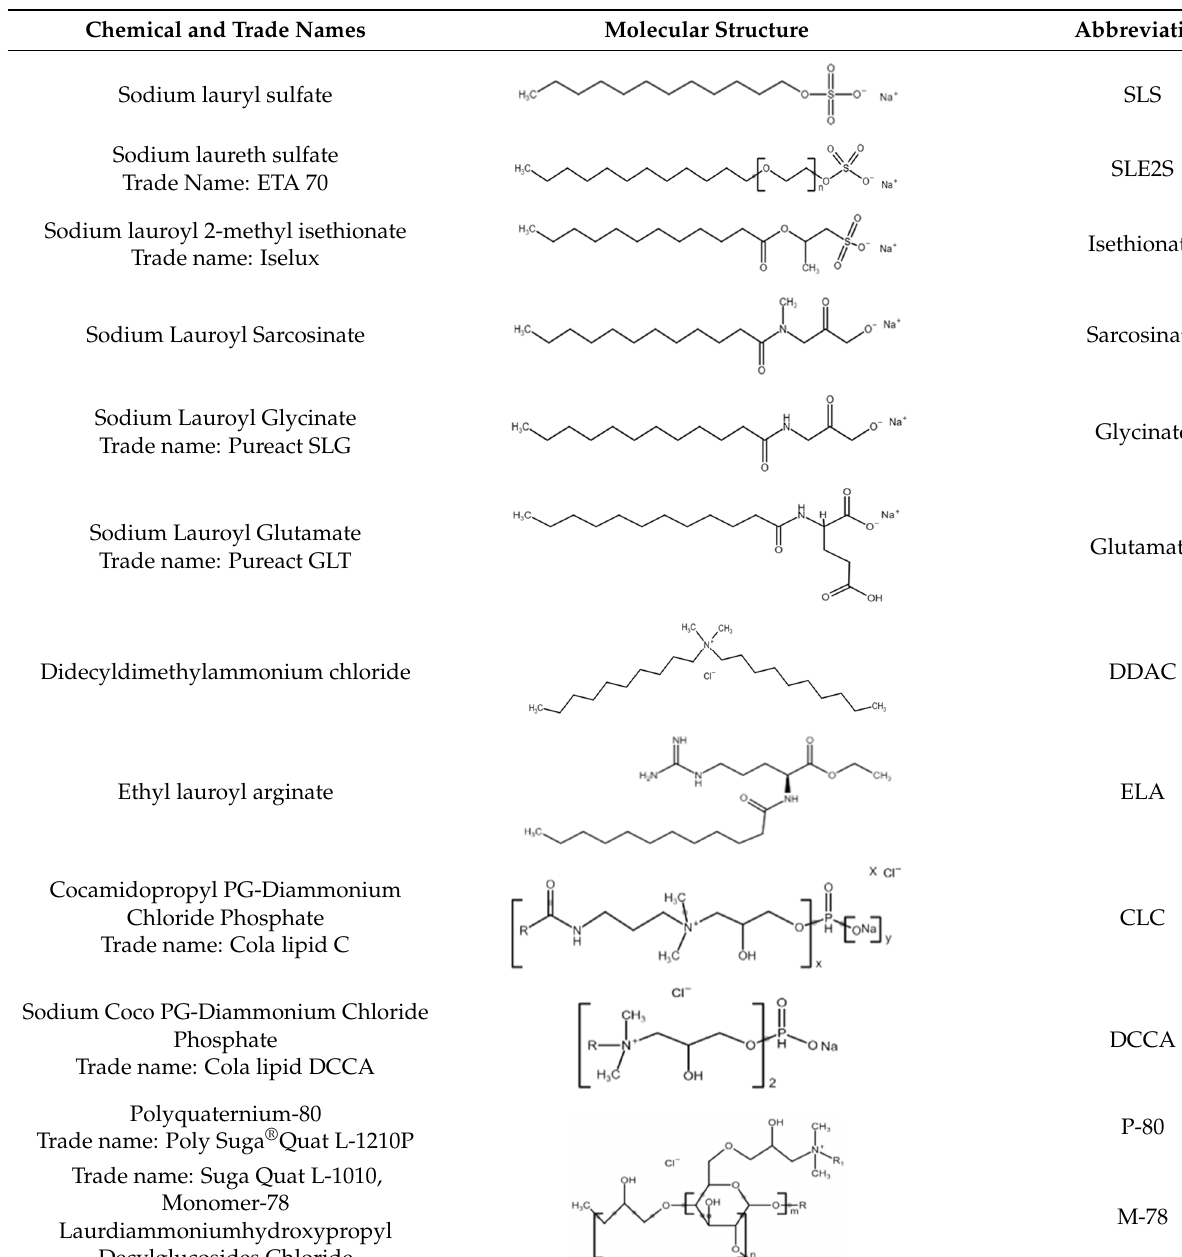
Table 1. Chemical and trade names, molecular structure, and abbreviation of the diverse cationic and anionic molecules studied in this work.